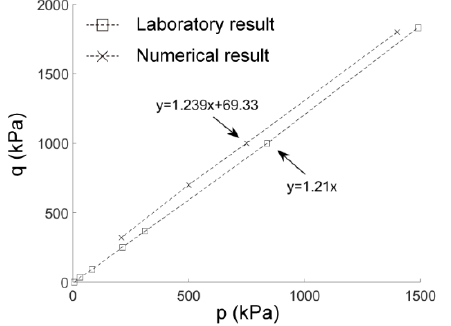
Figure 6. Failure envelopes for numerical calibration models and laboratory tests.